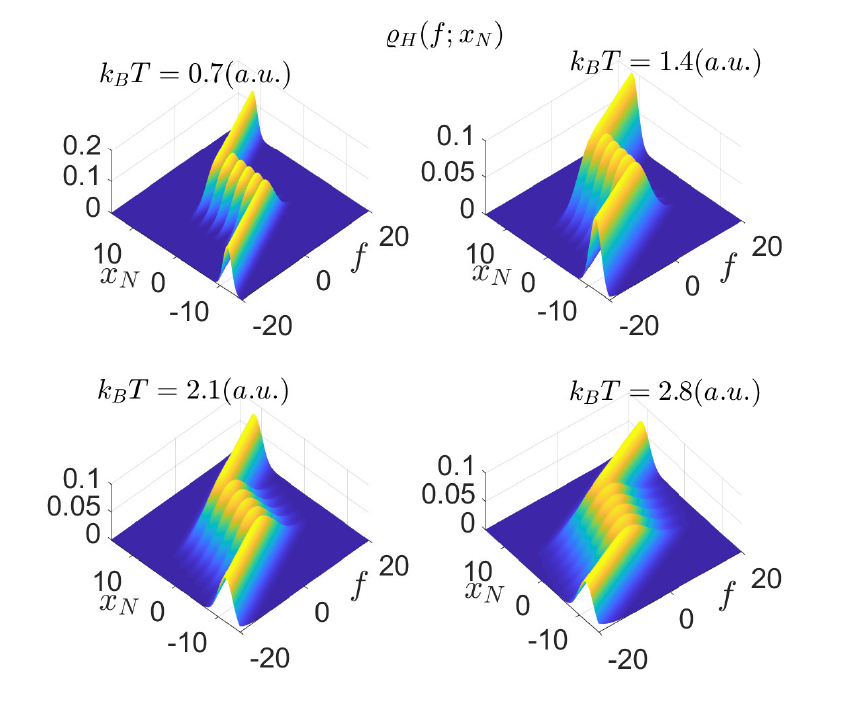
Figure 8. Three-dimensional representation of the Helmholtz density (cid:36) H ( f ; x N ) (see Equation (54)) obtained with N = 5, (cid:96) = 1 (a.u.), k = 15 (a.u.) and k B T = 0.7, 1.4, 2.1, 2.8 (a.u.).